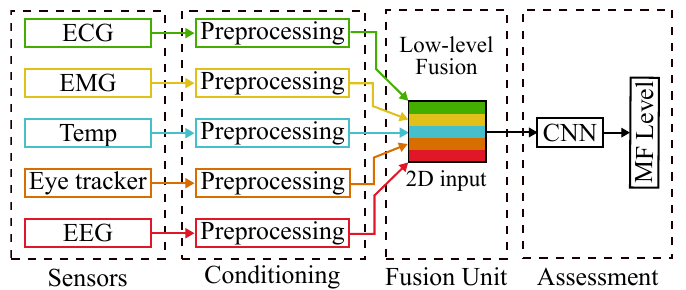
Figure 3. Proposed sensor fusion structure.